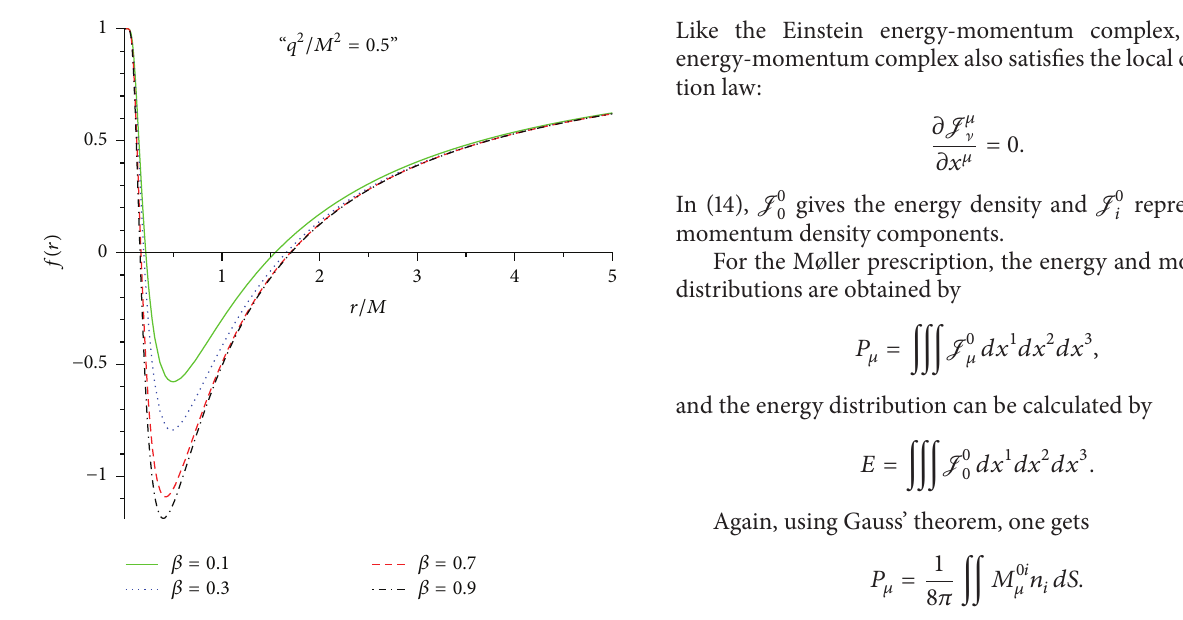
Figure 1: An inner and an outer horizon exist at the points where 𝑓(𝑟) meets the (𝑟/𝑀) -axis, here shown for four different values of the parameter 𝛽